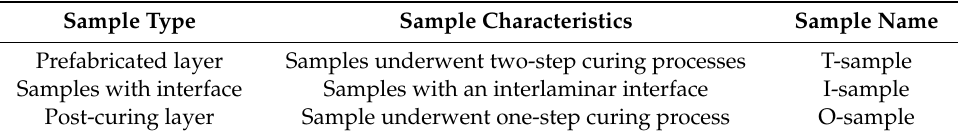
Table 2. Characteristics of the di ff erent types of samples.